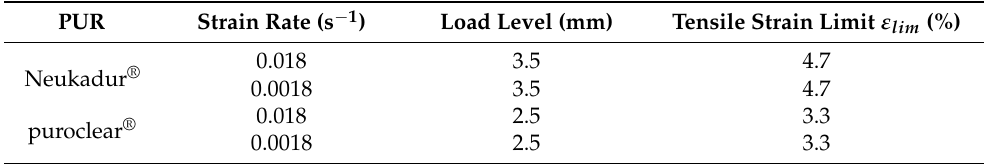
Table 2. Strain limits ε lim determined using the mechanical test method for Neukadur ® and puroclear ® under tensile